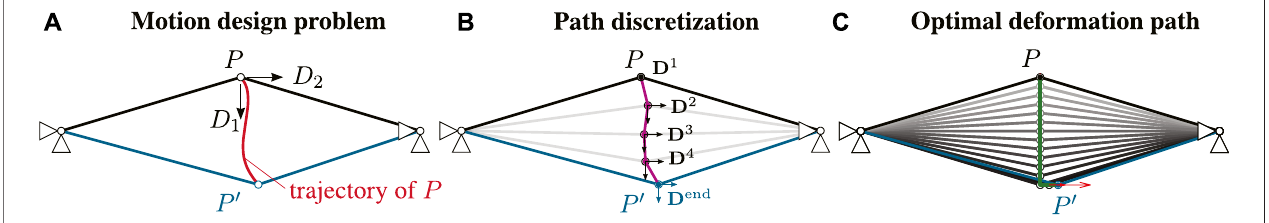
FIGURE 1 | Motion design of a two-bar truss. (A) Motion design Problem, (B) Path discretization, and (C) Optimal deformation